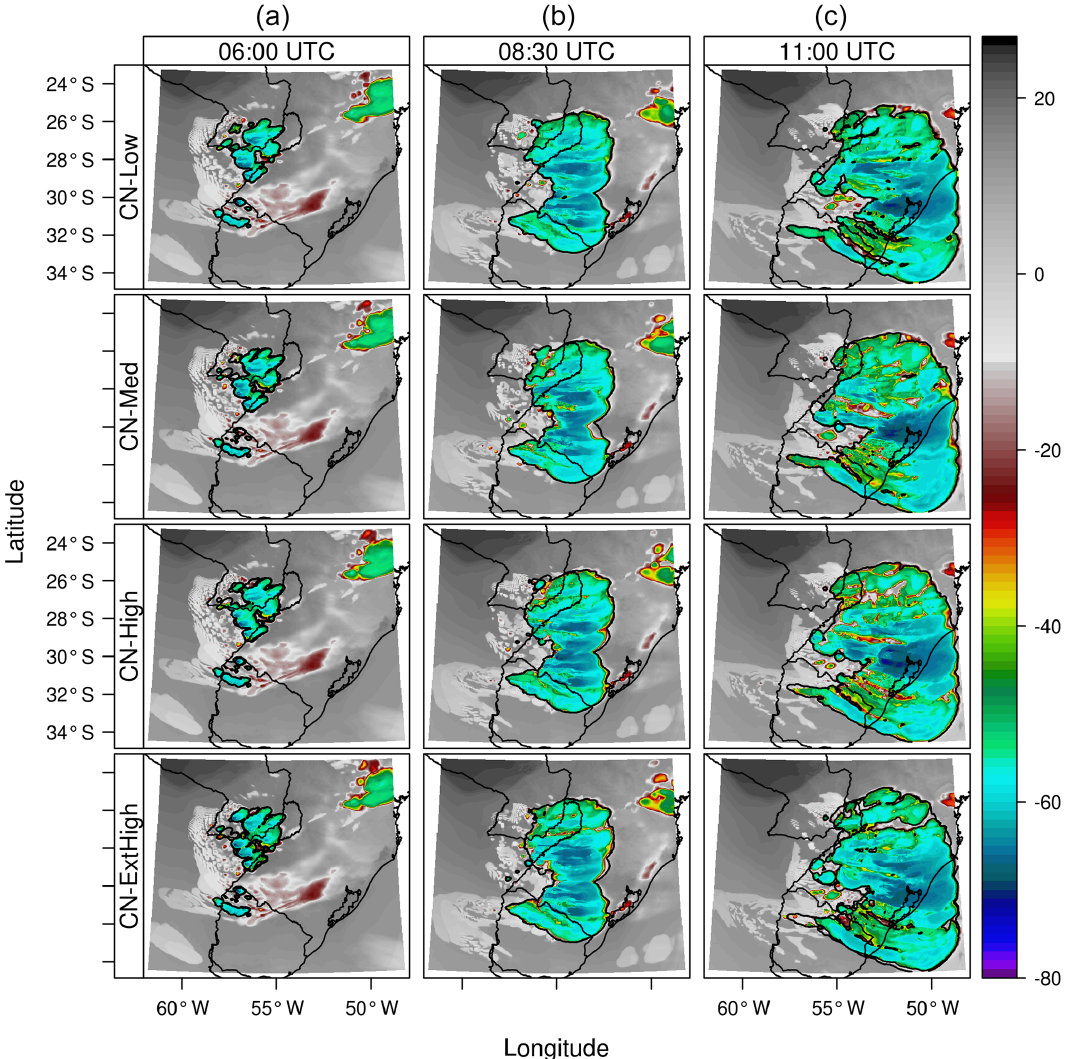
Figure 5. Synthetic infrared satellite images for the CN-Low, CN-Med, CN-High and CN-ExtHigh experiments at 06:00 (a) , 08:30 (b) and 11:00UTC (c) . Colors indicate brightness temperature at channel 10.7µm. The black contour line refers to the brightness temperature equal to − 32 ◦ C, which delimits the MCS area (Maddox,